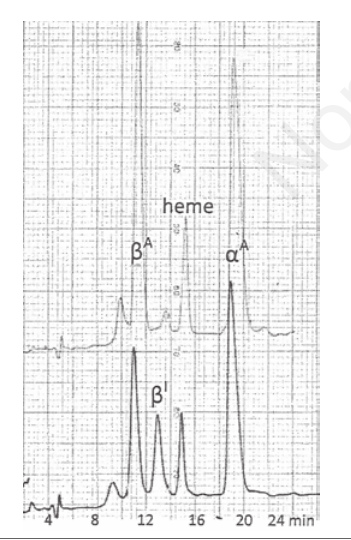
Figure 2. Reverse phase high-performance liquid chromatography profile of whole lysate from subject (lower trace) and con- trol (upper trace). Subject is heterozygous for more hydrophobic (cid:0)I chain making up 35% of the